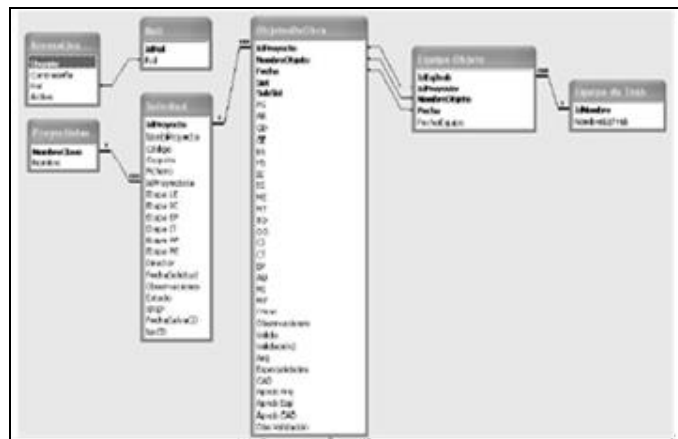
Figura 3: Relaciones de la BD en Microsoft Access. Fuente: Autor,